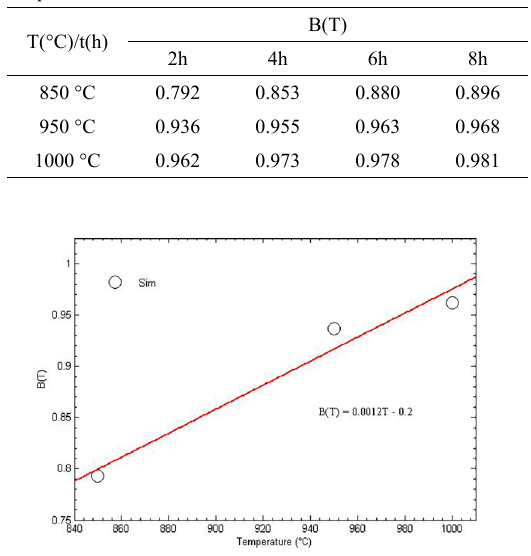
Figure 4. The B (T) Parameter as a function of temperature for 2hours treatment period. Table 5. The thickness of the boronized layer simulated with the equation (13) and the thickness obtained by using the experimental data. T(°C)/t(h)